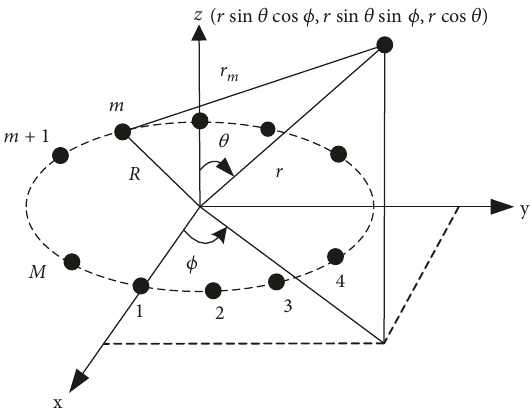
Figure 1: Geometry of circular array and